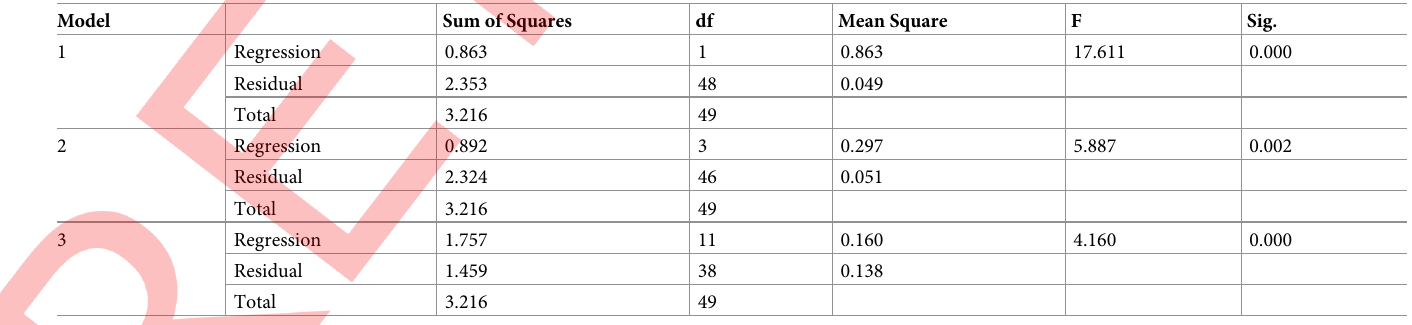
of residuals squares than the sum of regression squares indicates that the explanatory power of model is not sufficient. Multiple variables were included in the modeling to increase the explanatory power of the regression models. A summary of the multiple regression models is given in Table 7. In model 2, variables with correlation coefficients above 50% were included in the modeling. This model was able to explain 28% of the total variance in soil EC. In the third model, the independent variables with p < 0.05 were included in the modeling and the others were excluded. Accordingly, 11 independent variables with p < 0.05 were included in the modeling. Model 3 was able to explain 55% (R 2 = 0.55, p < 0.000) of the total variance in the dependent variable. In the ANOVA test, higher values for regression sum of squares than the sum of residual squares indicates that the model can successfully predict. In addition, nor- mal distribution for the scatter plot of the residuals indicates that the model is reliable (Fig 2). Table 8. The results of ANOVA test for linear regression.